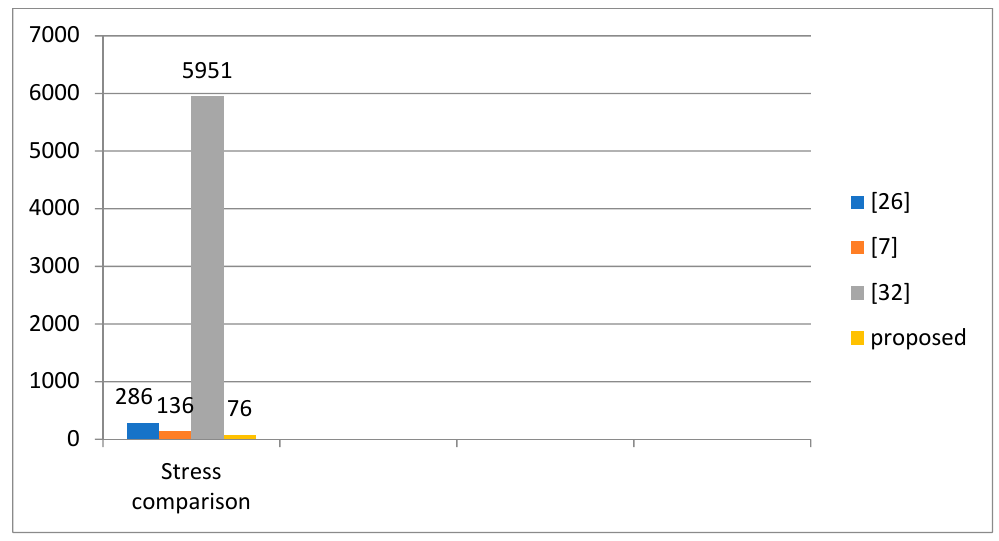
Figure 38. Switching stress comparison.